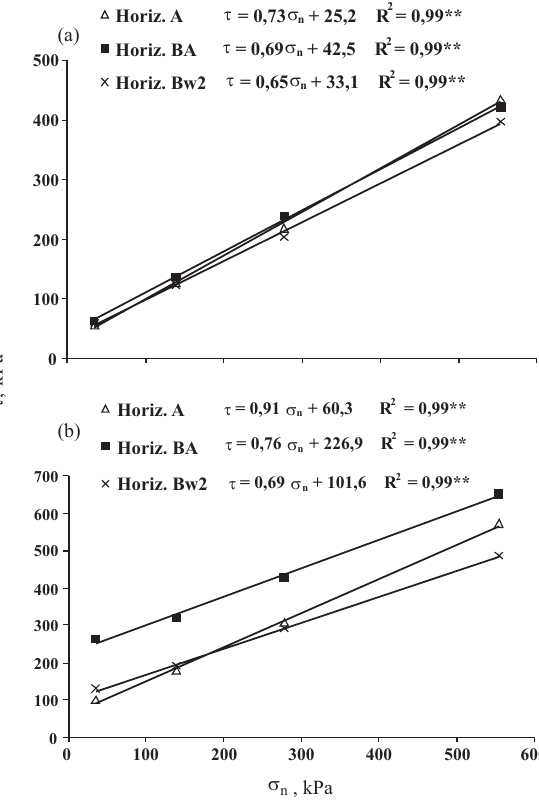
Figura 6. Tensão cisalhante ( τττττ ) como variável da ten- são normal ( σσσσσ ) de amostras dos horizontes coe- n so (BA) e não-coesos (A e Bw2) de um Latossolo Amarelo de São Miguel dos Campos, AL, nos te-